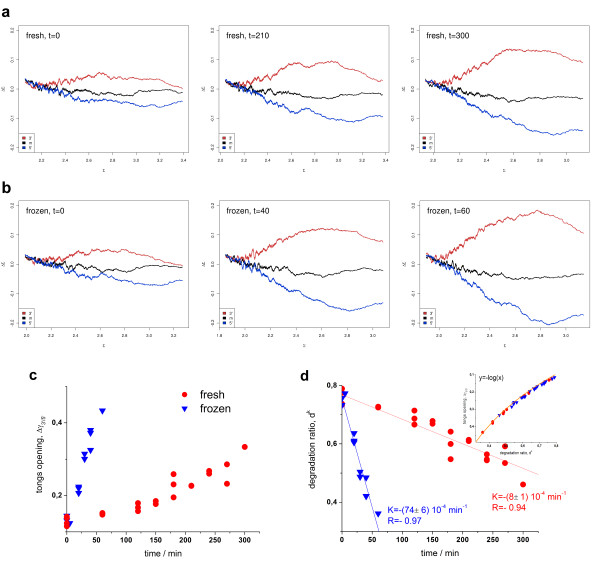
Collection of tongs plots taken from the ratQC data set. The RNA was extracted from liver samples either after ex vivo incubation of fresh tissue (panel a, incubation time 0, 210 and 300 min) or after thawing frozen tissue (b, incubation time 0, 40 and 60 min). The plots in panel c and d show the tongs-opening and the dk parameter of both series as a function of the incubation time, respectively. RNA prepared from frozen samples degrades much faster than RNA from fresh samples. The insert in part b correlates the dk and tongs opening parameters. Their relation follows a logarithmic function